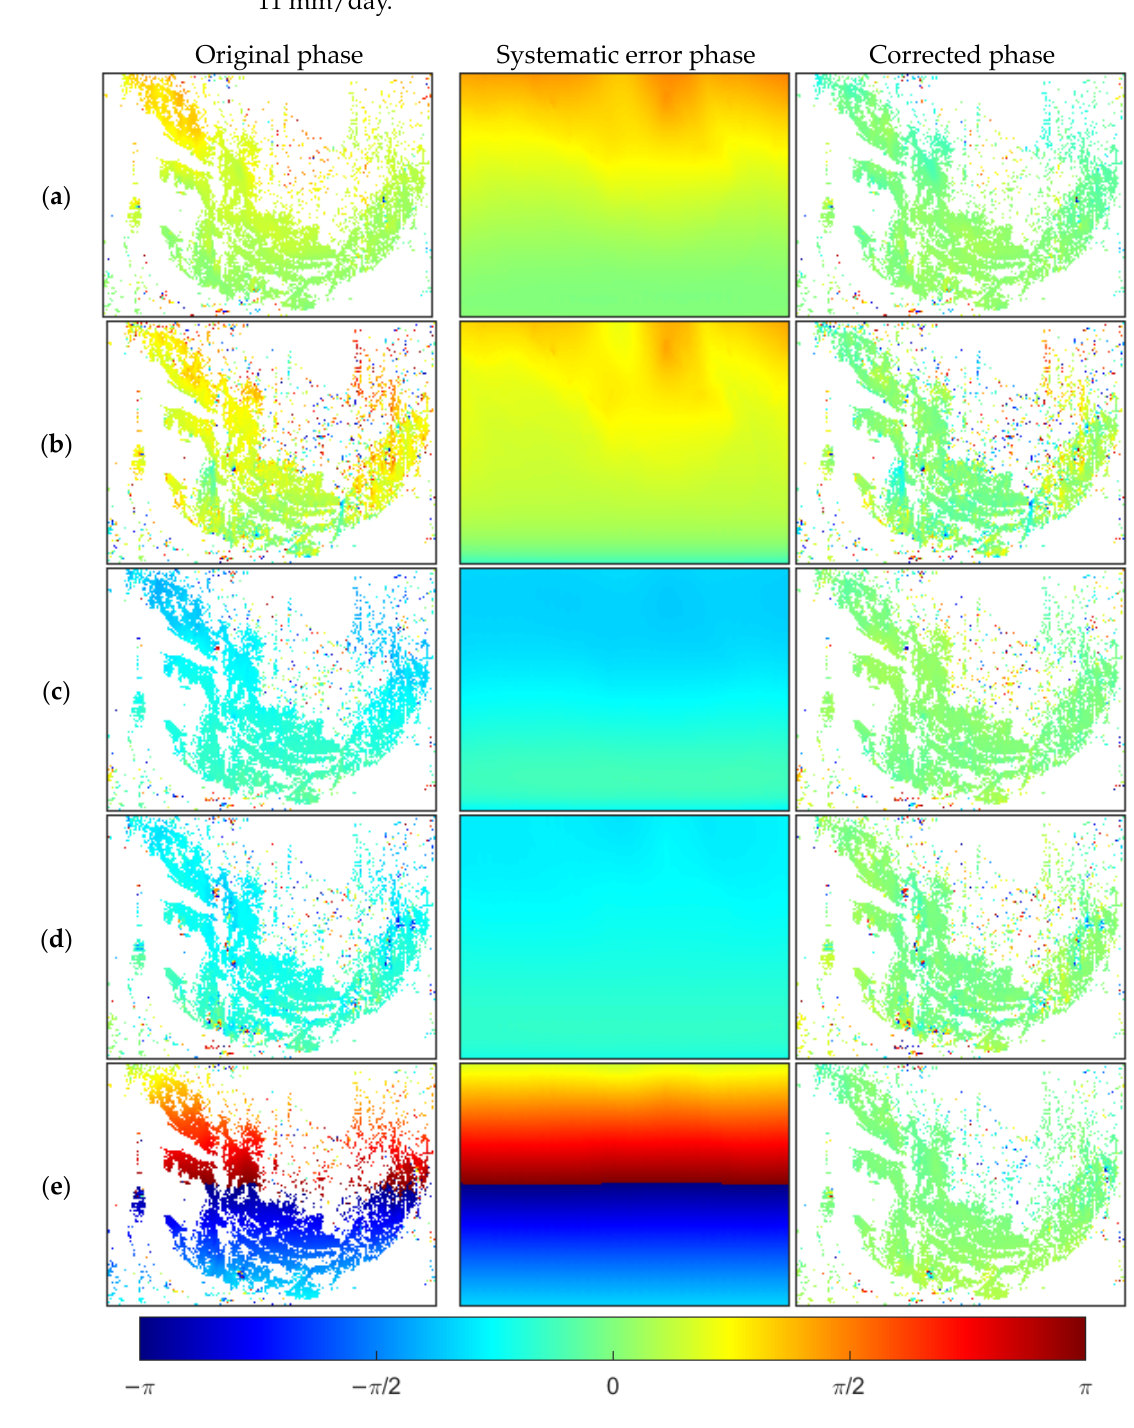
Figure 4. Original phase, systematic error phase, and corrected phase of five typical interference pairs in the experimental area. ( a , b ) Error related to elevation; ( c , d ) overall phase offset; ( e ) radar center deviation caused by blasting